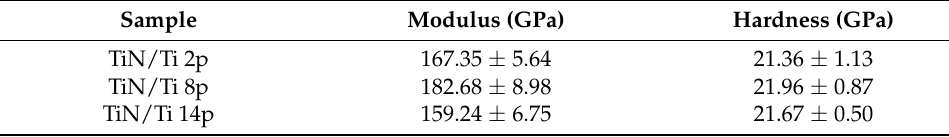
Table 3. Nano-indentation result of TiN/Ti